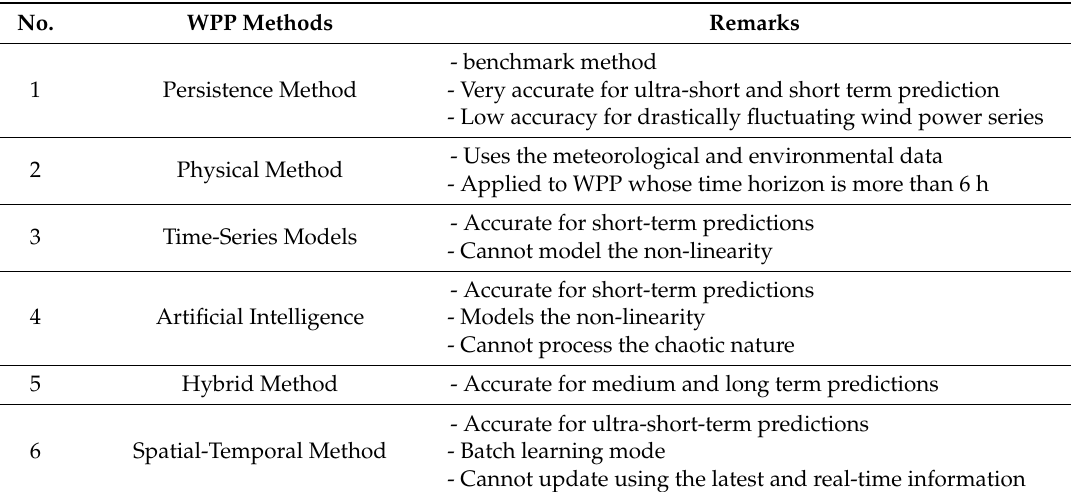
Table 2. The wind power prediction methods. WPP: wind power